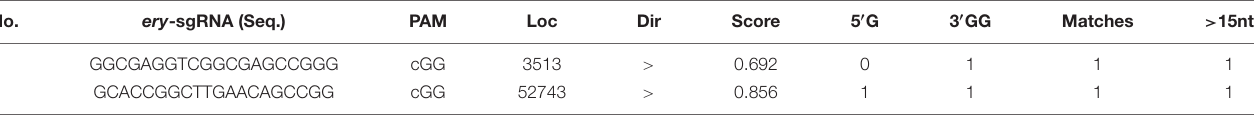
TABLE 1 | Details of two sgRNAs for knock-out of ery BGC.